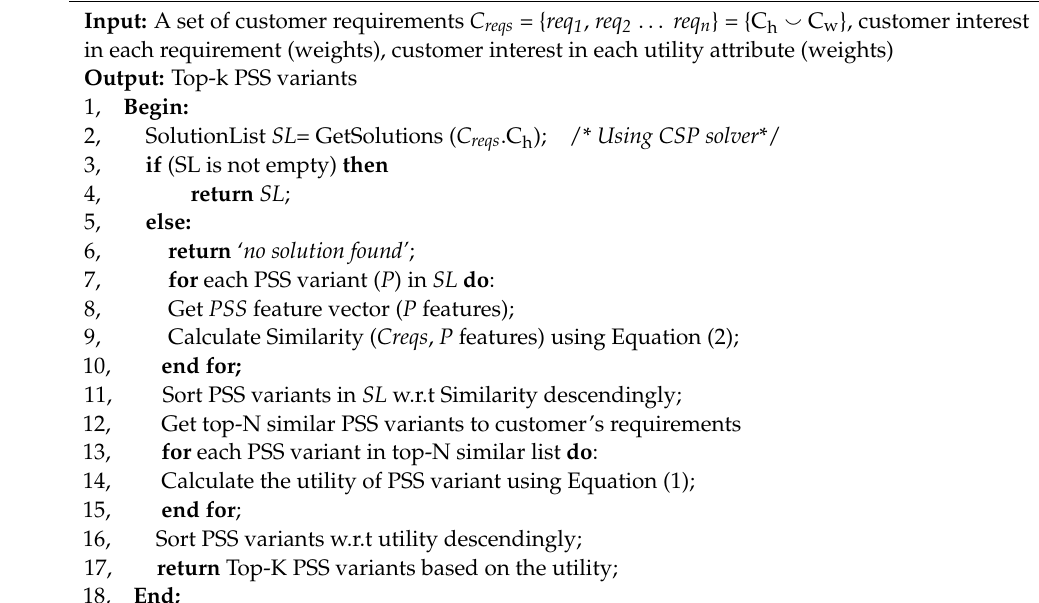
Algorithm 1 Handling cases in which no solution is